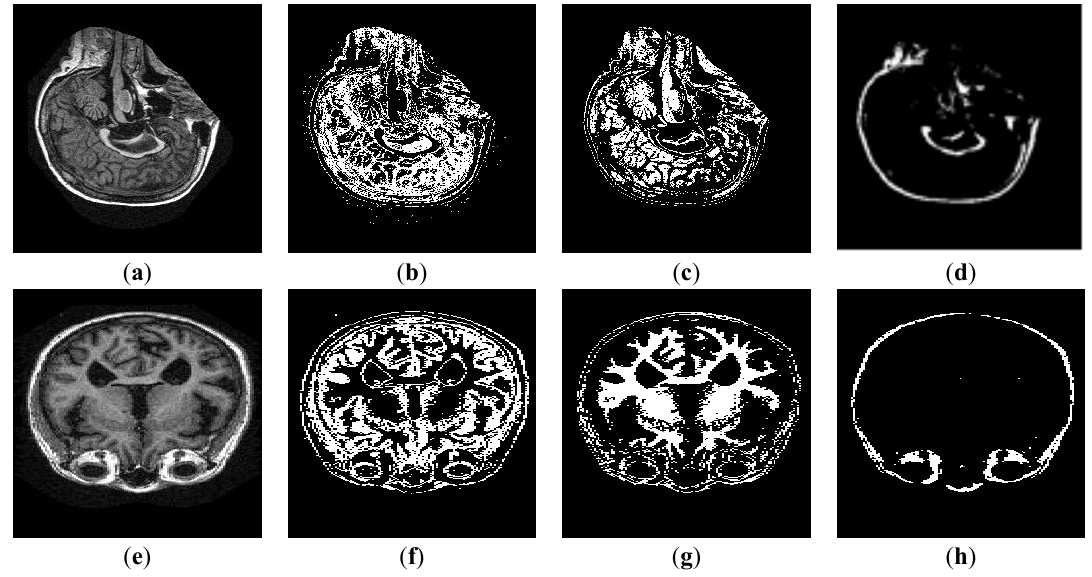
Figure 5. ( a , e ) Input-enhanced MRI. ( b , f ) GM segment of input MRI. ( c , g ) WM segment of input MRI. ( d , h ) CSF segment of input MRI.